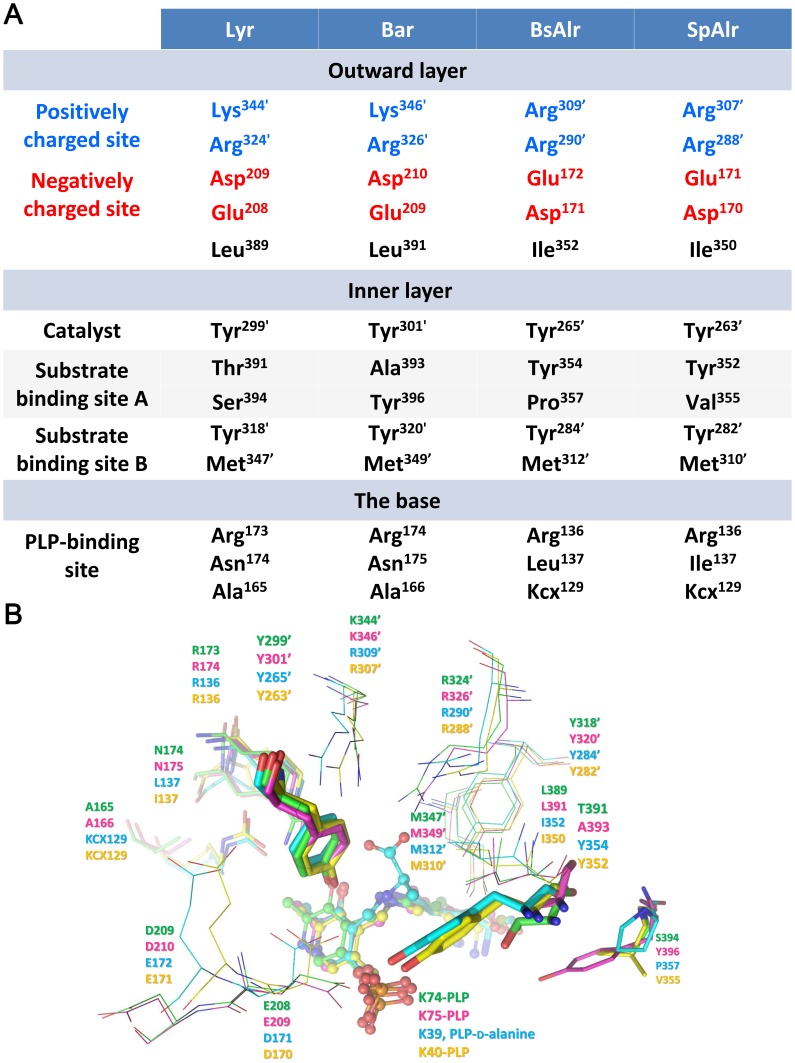
Crucial residues of binding cavities (See also Figure S1).(A) Crucial residues of Lyr, Bar, SpAlr and BsAlr in the binding cavities. (B) Superposition of binding cavities in Lyr (green), Bar (magenta), SpAlr (yellow), and BsAlr (cyan), respectively. Crucial residues are displayed as stick models. The ligands presented in binding pockets of all structures are drawn as ball-and-stick models. Oxygen, nitrogen, and phosphate atoms are colored red, blue, and orange, respectively.